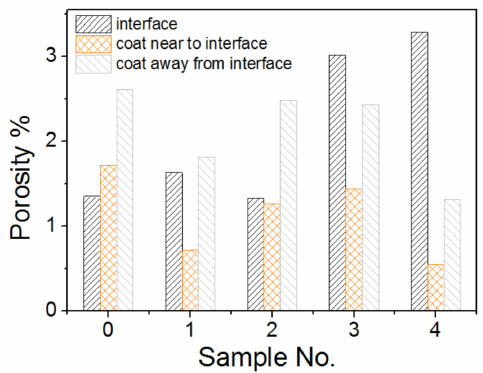
Figure 4. Porosity percentage of interfaces and coatings.